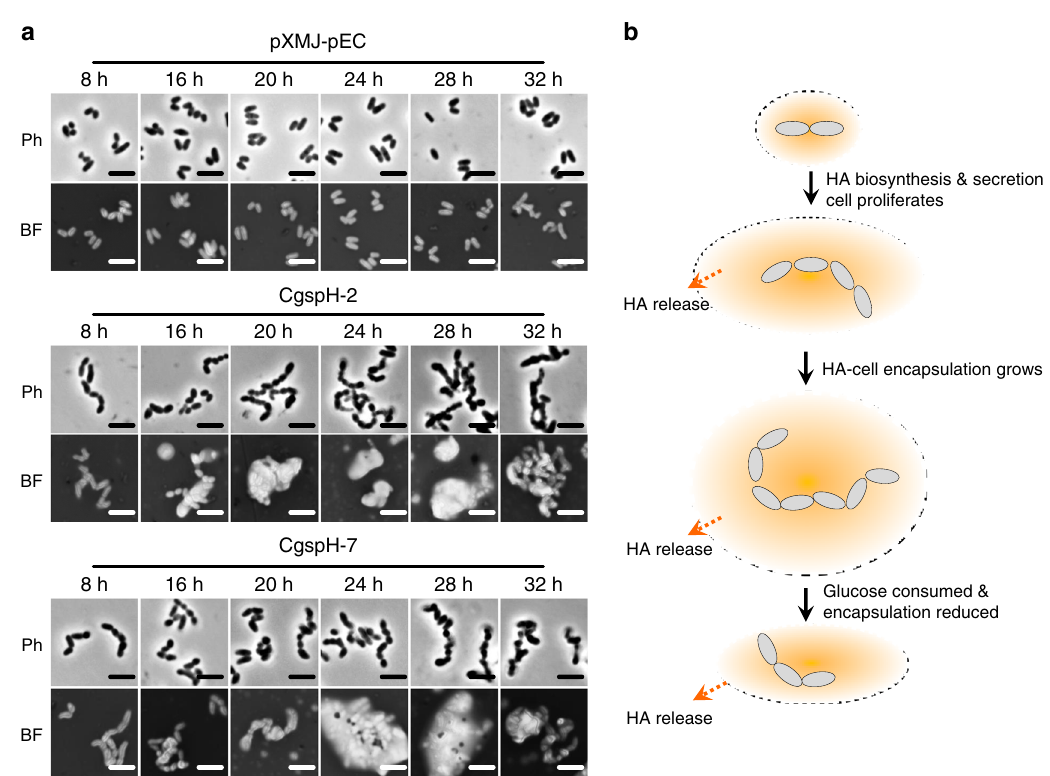
Fig. 3 Encapsulation of C. glutamicum cells by secreted HA. a Representative micrographs of C. glutamicum cells producing HA. Strains were cultivated in shake- fl asks. Cells were collected at designated time points for visualization by phase-contrast microscopy or under a bright fi eld after negative staining with 100 mg mL − 1 water-soluble nigrosin for 5 minutes. Ph, phase-contrast microscopy; BF, bright- fi eld microscopy. Scale bar, 2.5 μ m. Microcopy experiments were performed three times independently with similar results. b A proposed model of HA secretion, encapsulation and release. Source data underlying Fig. 3a are provided as a Source data fi